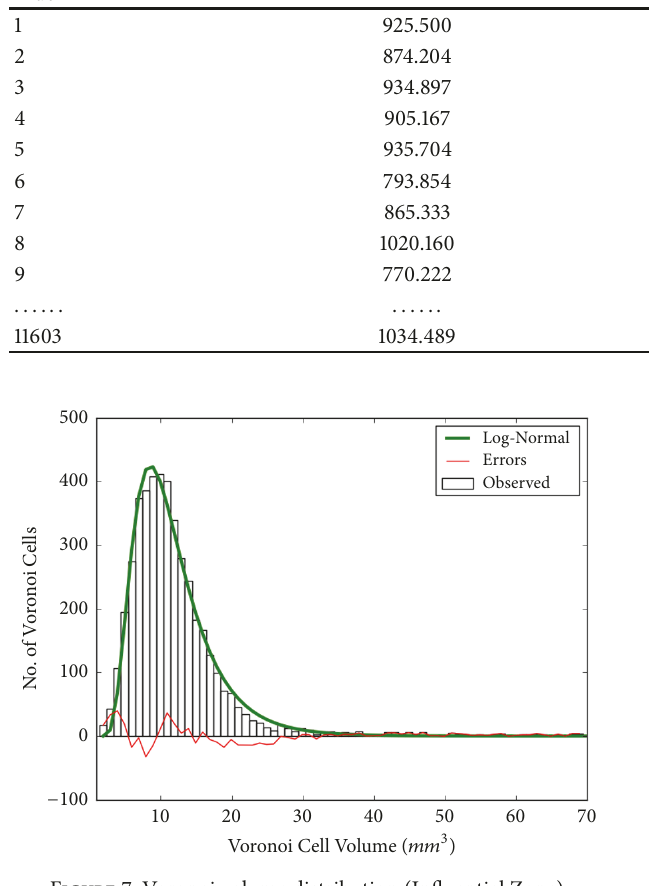
Figure 7: Voronoi volume distribution (Influential Zone). Figure 8: Nearest neighbor